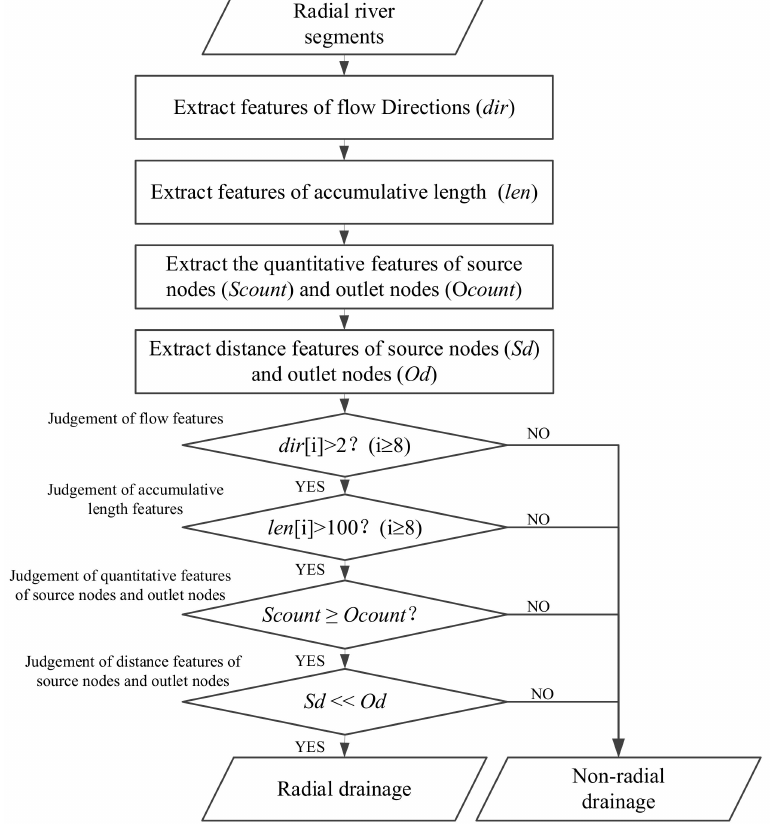
Figure 10. The flow diagram of RD